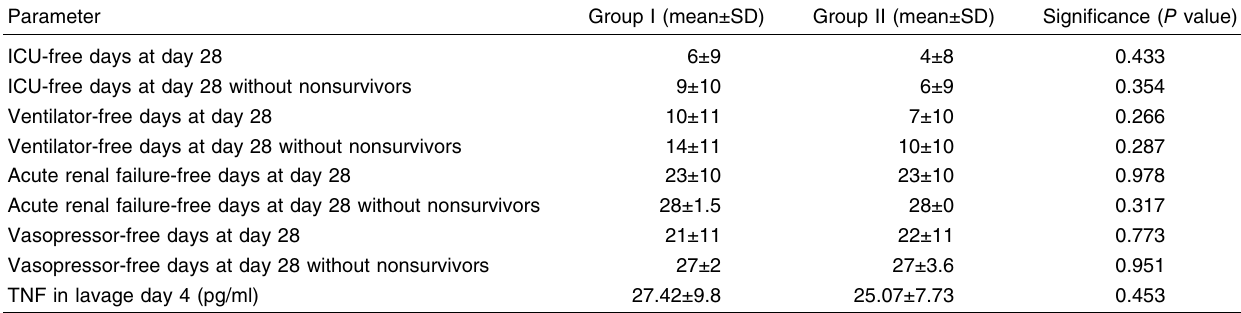
Table 13 Comparison between the two groups regarding endpoint parameters using the Mann–Whitney U